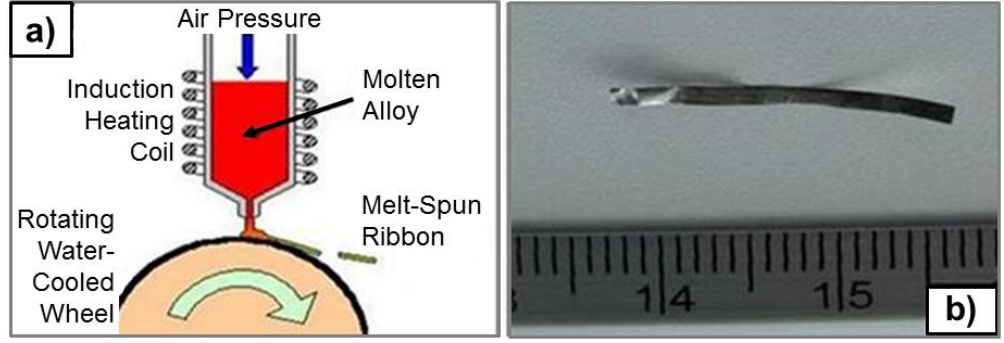
Figure 1. Melt-spinning process. ( a ) Schema. ( b ) Resulting NiTi ribbon (measures in